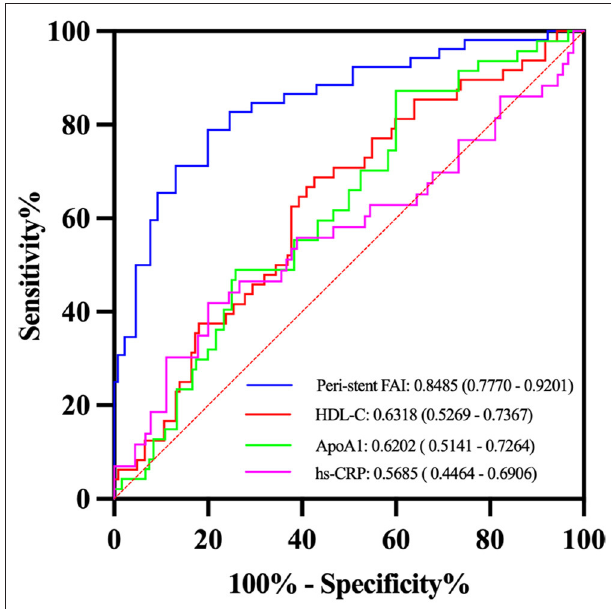
FIGURE 5 | Receiver operator characteristic (ROC) curves analysis of selected variables for detection of ISR. The peri-stent FAI had the best performance with an AUC value of 0.85.